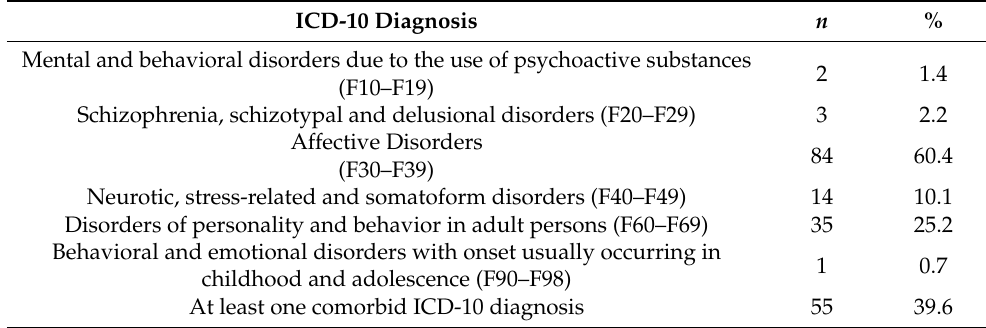
Table 1. Distribution of ICD-10 diagnoses among mentally ill parents ( n = 139). ICD-10 Diagnosis n % Mental and behavioral disorders due to the use of psychoactive substances